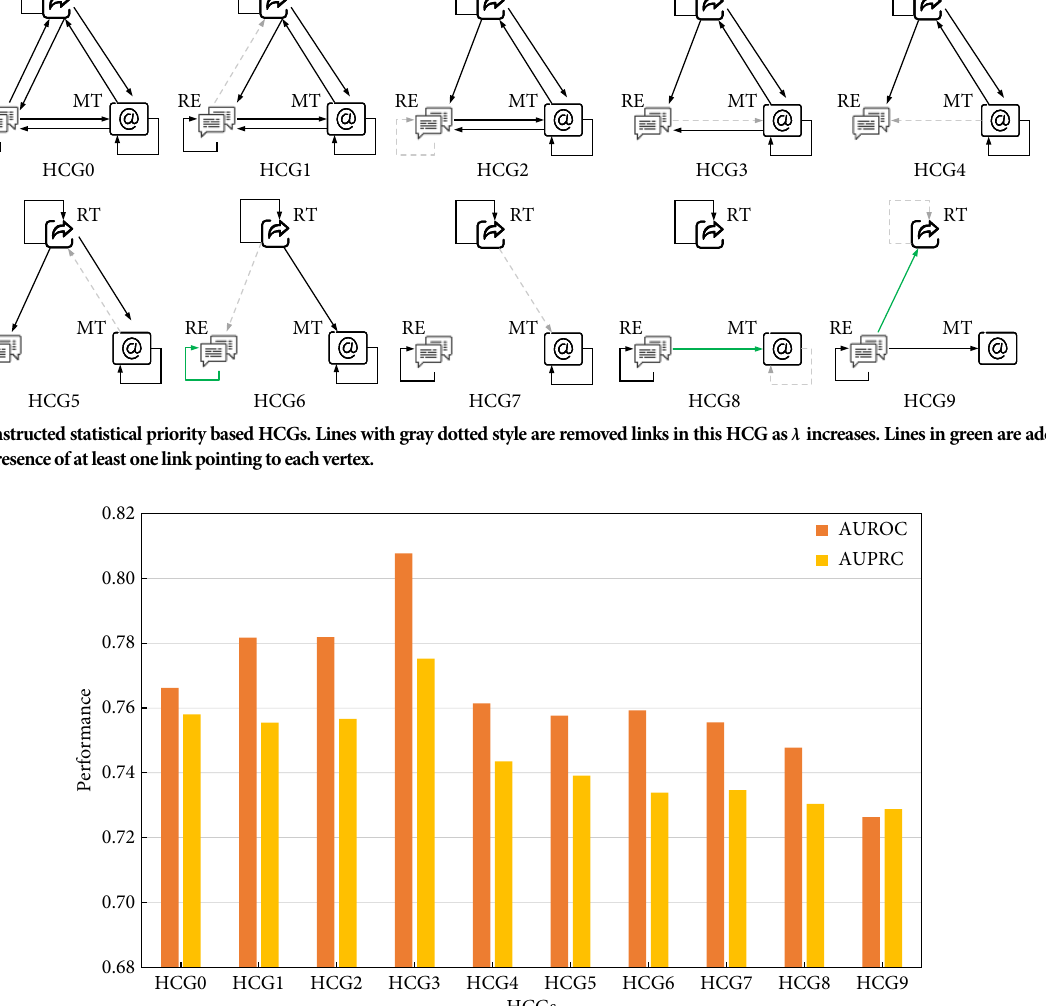
Fig. 11 Performance of different HCGs in the link prediction task.